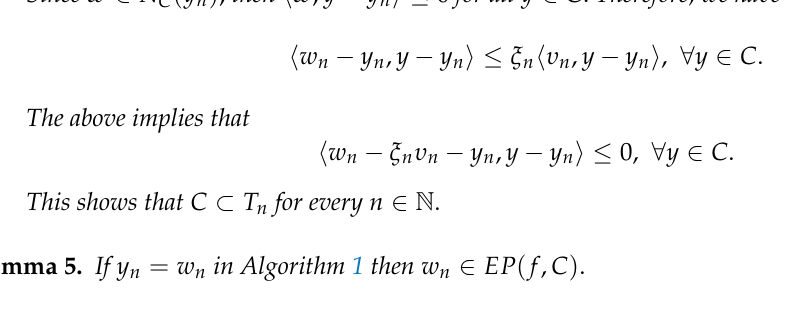
Algorithm 1 Inertial Explicit Extragradient Algorithm for Pseudomonotone